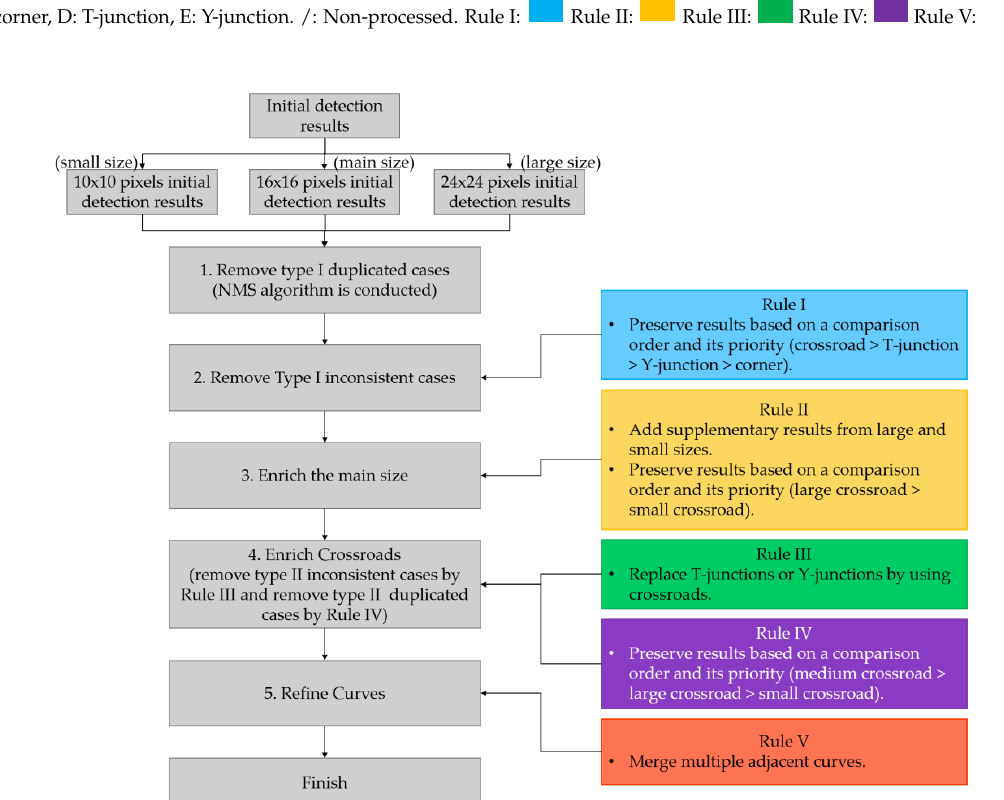
A: crossroad, B: curve, C: corner, D: T-junction, E: Y-junction. /: Non-processed Rule I: Rule II: